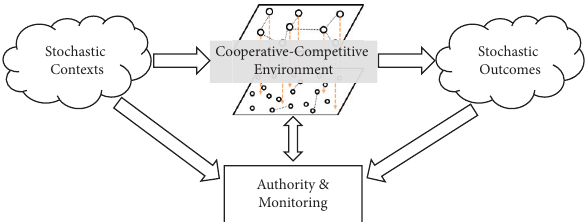
Figure 3: Information and behavioural feedback loops within the OPTN. Both stochastic processes and their own cooperative- competitive environment govern the interorganizational